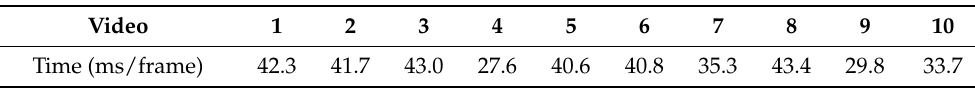
Table 6. Execution time of MB-TALBP (Multi-Block Temporal-Analyzing Local Binary Pattern) in software